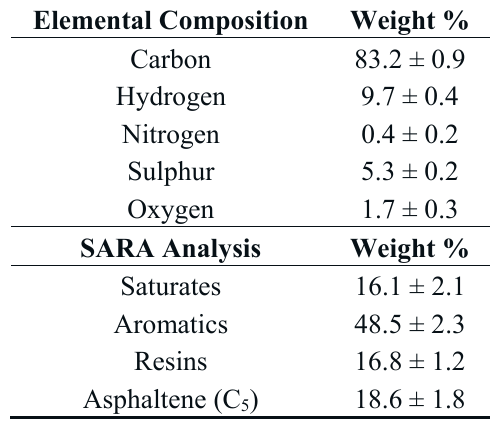
Table 1. Composition analyses of Athabasca bitumen (adapted from Bazyleva et al . [5], with permission from © 2011 American Chemical